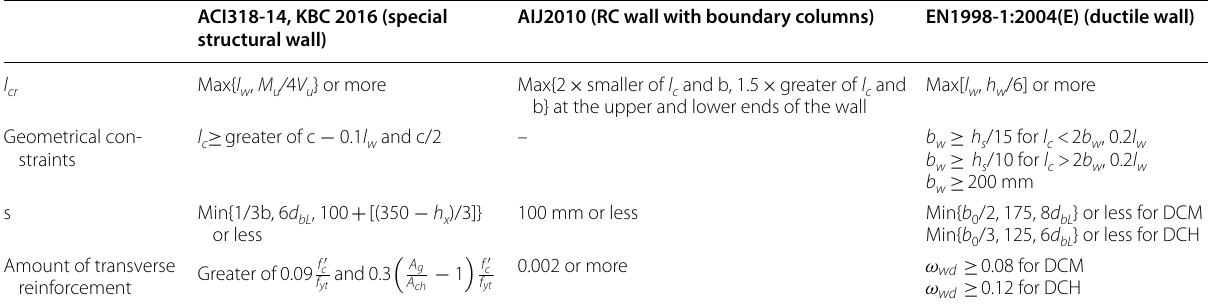
Table 1 Special provisions for shear walls with boundary elements.